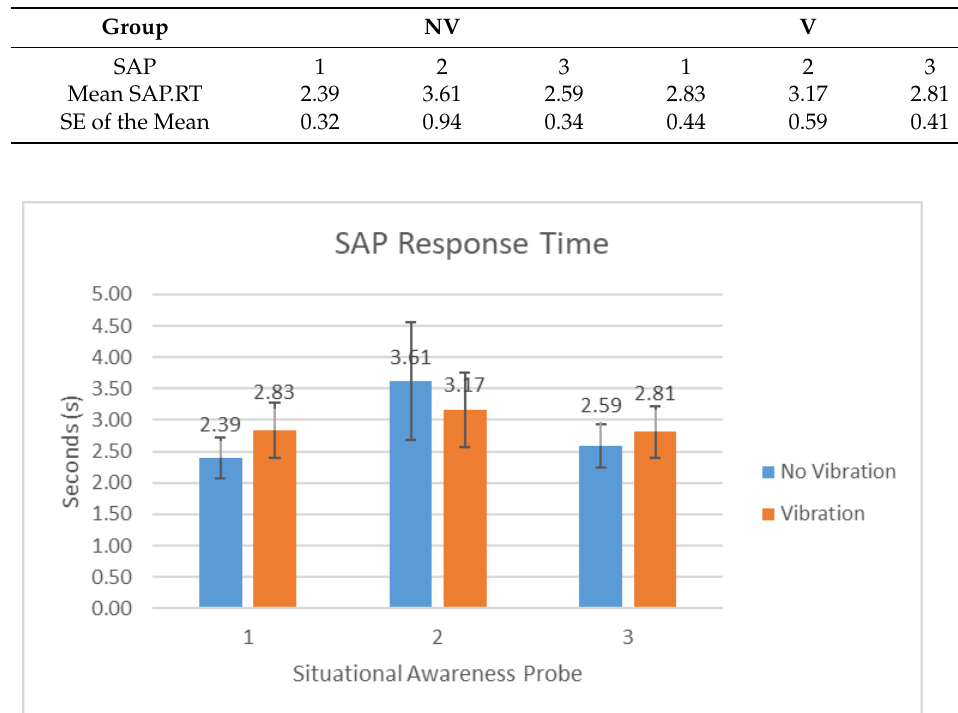
Figure 8. Situation awareness probe response time (SAP.RT) to the three situation awareness probes (SAPs) for each participant group, “No Vibration” (NV) and “Vibration” (V). Bars provide mean values with error bars representing standard error of the mean.